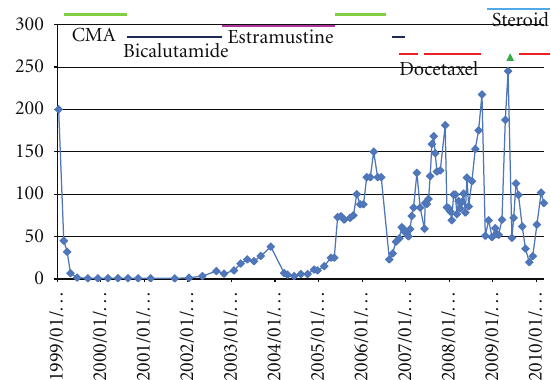
Figure 2: PSA course of a hormone-refractory prostate cancer patient whose PSA declined due to surgical castration. gical castration, CMA: chlormadinone acetate, vertical line: PSA (ng/mL), horizontal line: date. Before surgical castration, dose of docetaxel every other week was 35 mg/m 2 per